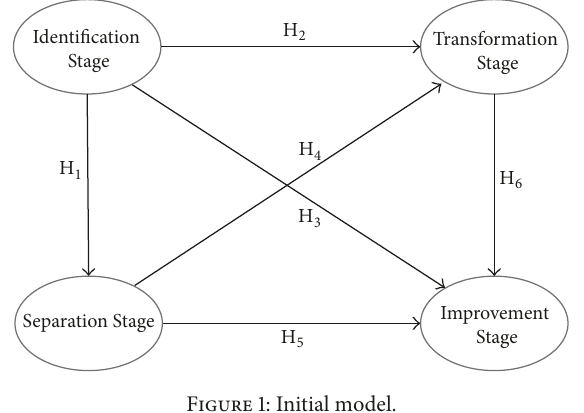
Figure 1: Initial